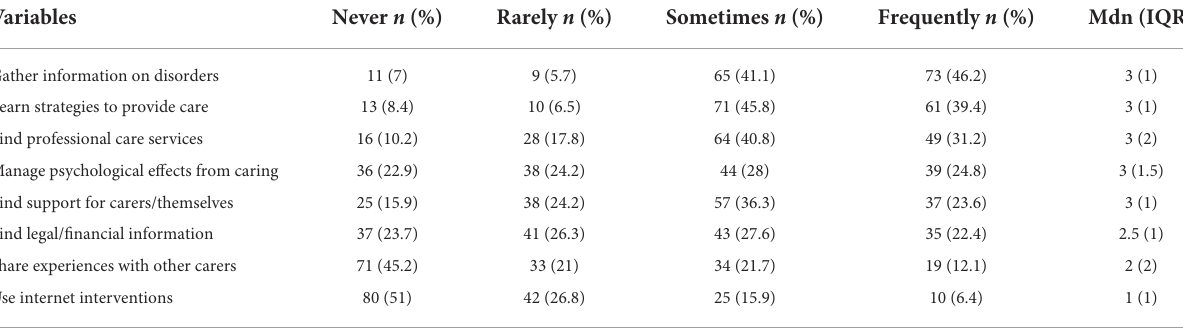
TABLE 3 The reported frequency of internet use for dementia and caregiving-related purposes: descriptive statistics ( N = 158).